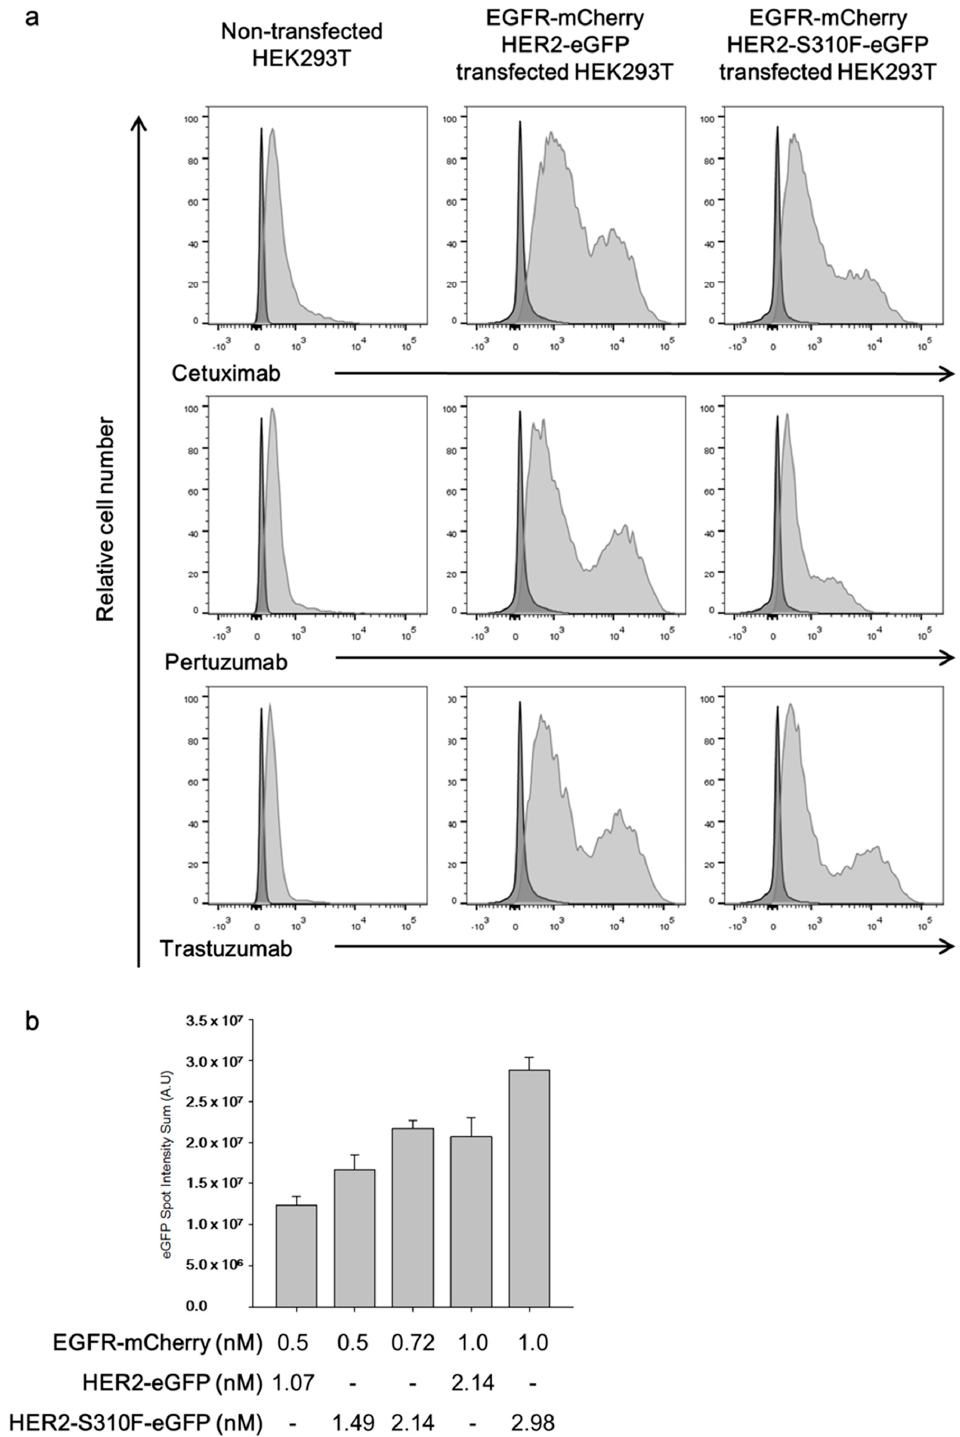
Figure 4. Single-molecular interaction analysis for the S310F mutant and EGFR heterodimerization. HEK293T cells were transfected with expression vectors encoding either EGFR-mCherry and wild-type HER2-eGFP or EGFR-mCherry and S310F HER2-eGFP fusion proteins. ( a ) After transfection, the cell surface expression of EGFR and HER2 or HER2 was checked by flow cytometry analysis using cetuximab, pertuzumab, and trastuzumab in the scFv-human C κ format and APC-labeled anti-human C κ antibody. ( b ) The lysates were subjected to a flow chamber coated with anti-mCherry antibody. Then, the summed intensity of eGFP spots was measured and plotted. Results represent the mean ± SD obtained from experiments performed in